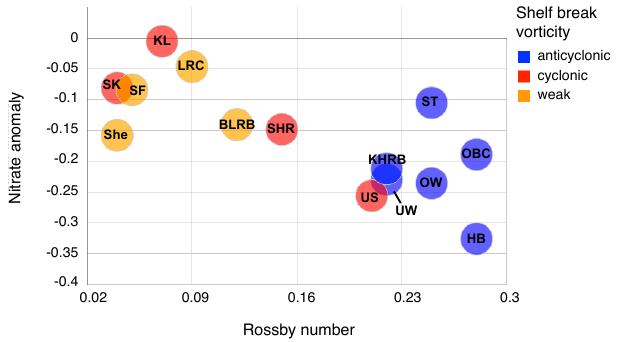
Figure 17. Incoming Rossby number effect on nitrate anomaly for all simulations (averaged between model days 4 and